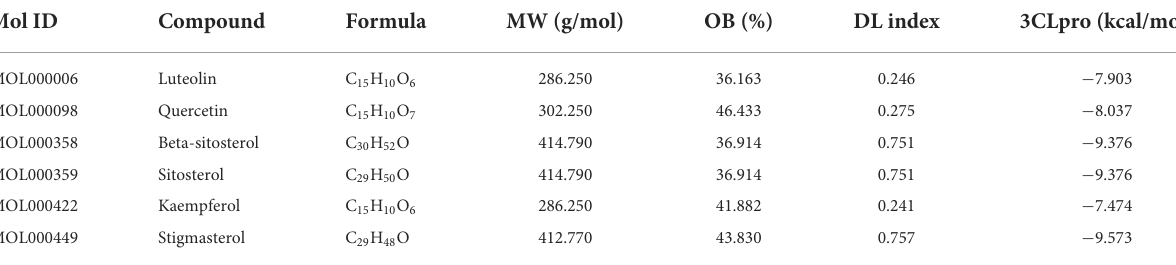
TABLE 3 Docking model of the common active ingredients of CSTRG with MAPK14 protein. Mol